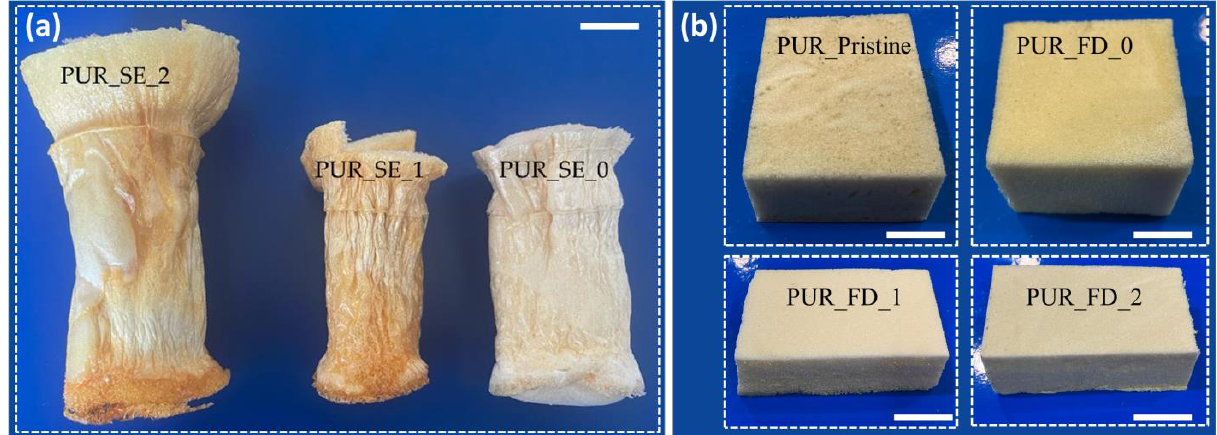
Figure 4. Digital reproductions of ( a ) PUR_SE_0, PUR_SE_1 and PUR_SE_2 foams, where CNCs were obtained through solvent-exchange procedure, and of ( b ) PUR_Pristine, and of PUR_FD_0, PUR_FD_1 and PUR_FD_2, for which CNCs were obtained through freeze-drying procedure. Scale bar = 1 cm.